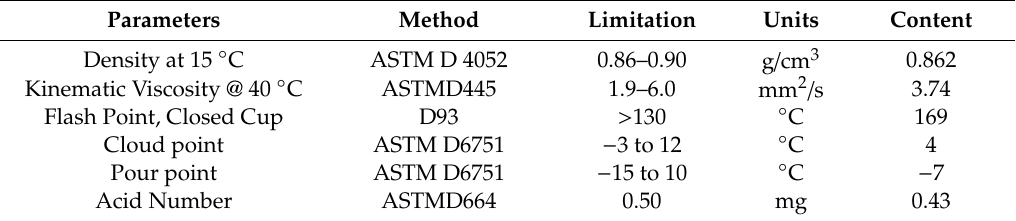
Table 3. Properties of the biodiesel produced from C.